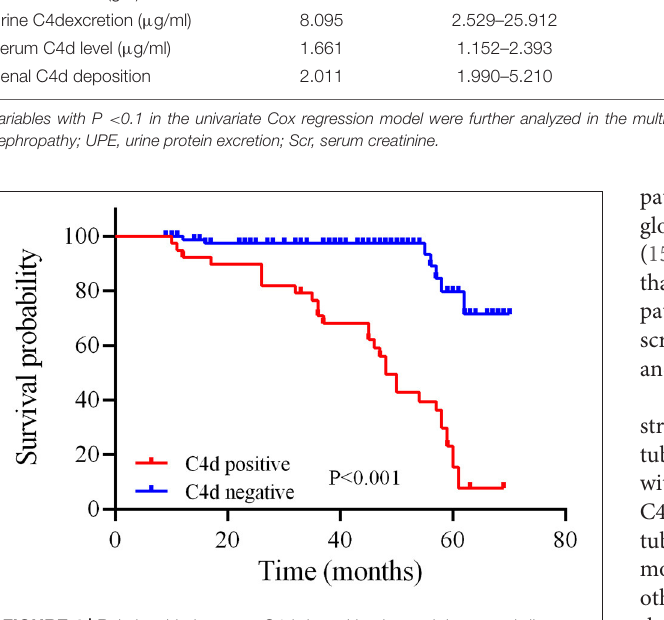
FIGURE 4 | Relationship between C4d deposition in renal tissue and disease progression by time of IgAN patients. The red and blue line separately illustrate the survival probability over time for IgAN patients with positive or negative renal C4d deposition. Kaplan-Meier analysis with log-rank test revealed a significant difference between groups ( P <